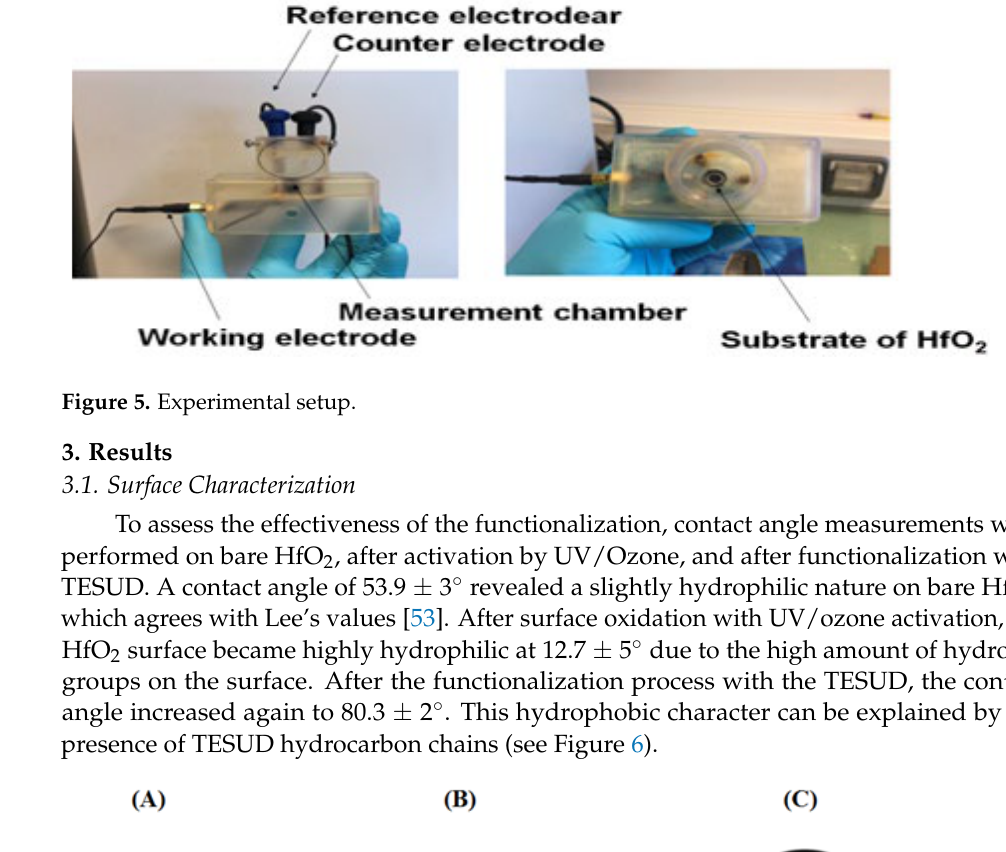
Figure 7. ( A ) Example of Nyquist plots for the Randles equivalent circuit model obtained by ana- lyzing cortisol standard solutions in PBS (2, 10, 15, and 50 ng mL −1 ). EIS frequency ranged from 5 Hz to 100 kHz, and a sinus amplitude of 25 mV with polarization potential of − 1.5 V; ( B ) sensitivity curves obtained by analyzing standard solution containing cortisol or other HF biomarkers